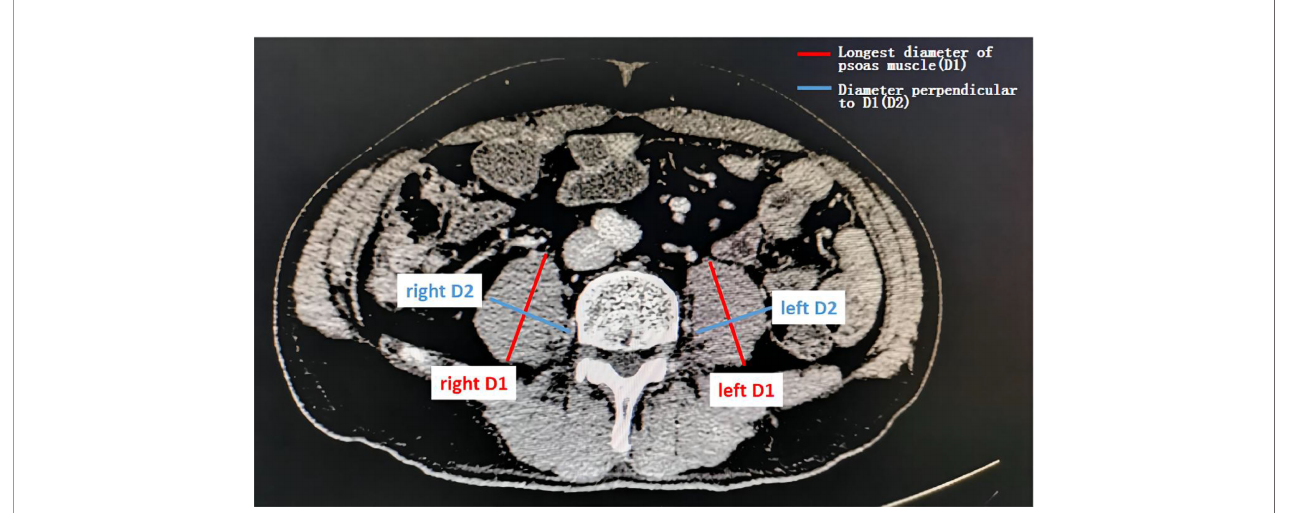
FIGURE 1 | Assessment of the psoas muscle index (PMI). Sarcopenia was assessed by measuring the longest diameter (D1) and the perpendicular diameter (D2) of the right (ri) and left (le) psoas muscle on an axial computed tomography (CT) scan in the same plane and normalizing it for the patients ’ height squared. This value is referred to as the psoas muscle index